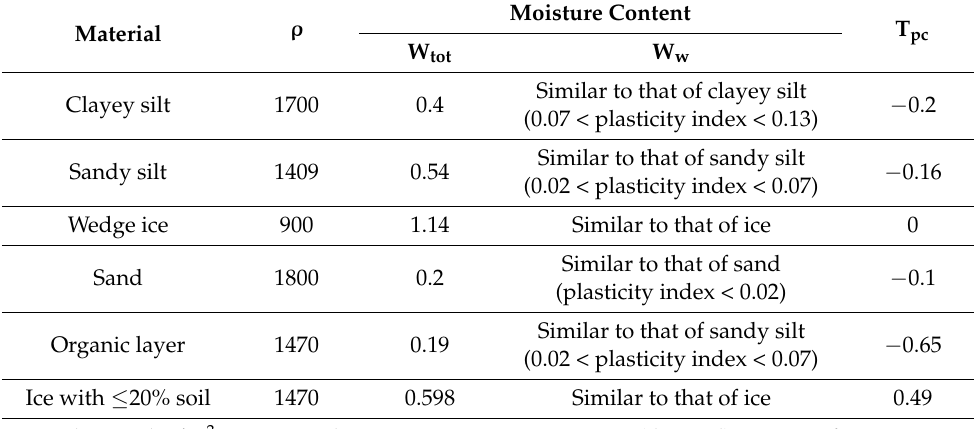
Table 4. Physical properties of materials in the